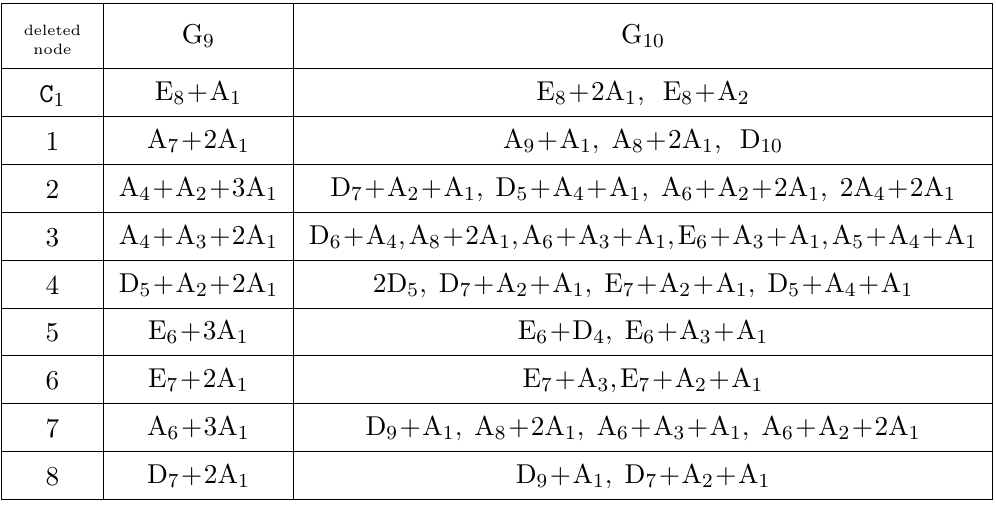
Table 9. Maximal enhancements G 10 + E 8 in the neighborhood of A 1 = 0, A 2 = 0, E ij = (cid:14) ij